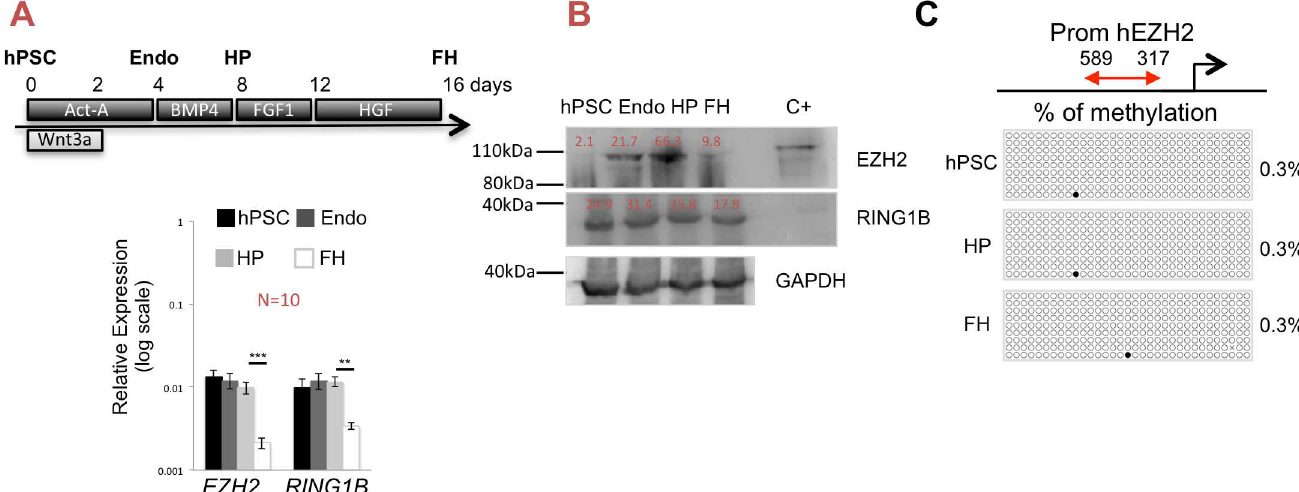
Fig 1. EZH2 expressionduring hepatocyte differentiation. A. Upper part, differentiationprotocolof hPSCs into hepatocytes-like cells. hESC were harvestedand platedat ± 7 x 10 4 cell/cm 2 and differentiatedwith a combination of growth factors: 50ng/mlof Activin-A and Wnt3a for the first 2 days and 50ng/mlActivin-A until day 4, followedby BMP4 50 ng/ml from day 4 until day 8, FGF1 50 ng/ml from day 8 until day 12, and HGF 20 ng/ml from day 12 until day 16. Differentiated progenyof the hESC line were harvestedon day 4 (endo_d4,definitive endodermcells), on day 8 (HP_d8, hepatoblast progenitor) and on day 16 (FH_d16, fetal hepatocyte). Bottom part, transcript expressionlevels of EZH2 and RING1B in hPSCs, endo, HP and FH stages. GAPDH was used as a control. Data as mean ± SEM of n (cid:21) 3 IEs. *** p < 0.001 by Student’s t test. B. Western blot analysisof EZH2, RING1B and GAPDH on hPSCs, endo, HP and FH stages. GAPDH was used as loadingcontrol. HEK293T transiently transfected with pLVX-IRES-Hygro- hEZH2 cells were used as positive control. Signals were quantified and indicatedas % to loadingcontrol. C. Schematicrepresentation of the EZH2 regulatory region. Approximately 270bp (arrow in front of the TTS) in a CpG island were bisulfitesequencedin undifferentiated hPSC, HP and FH. Percentages of the results of bisulfitesequencing of the regionsare at right side of the figure for each stage.